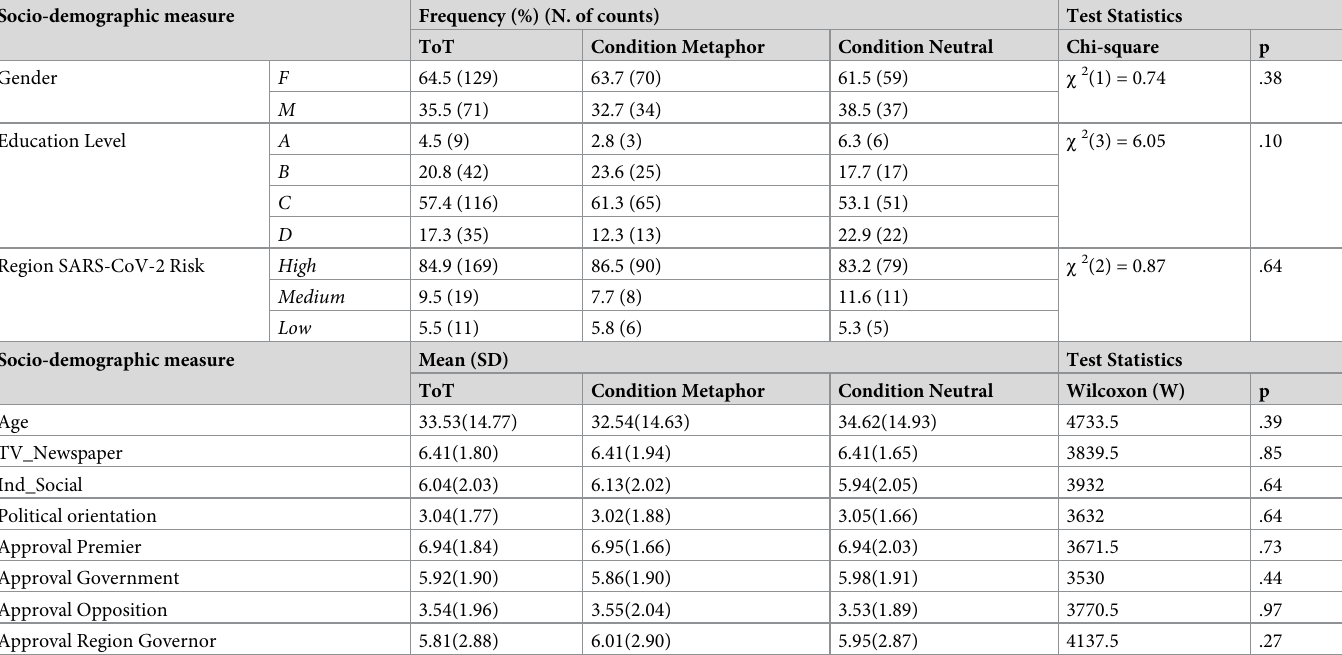
Table 1. Descriptive and inferential statistics for the set of socio-demographic